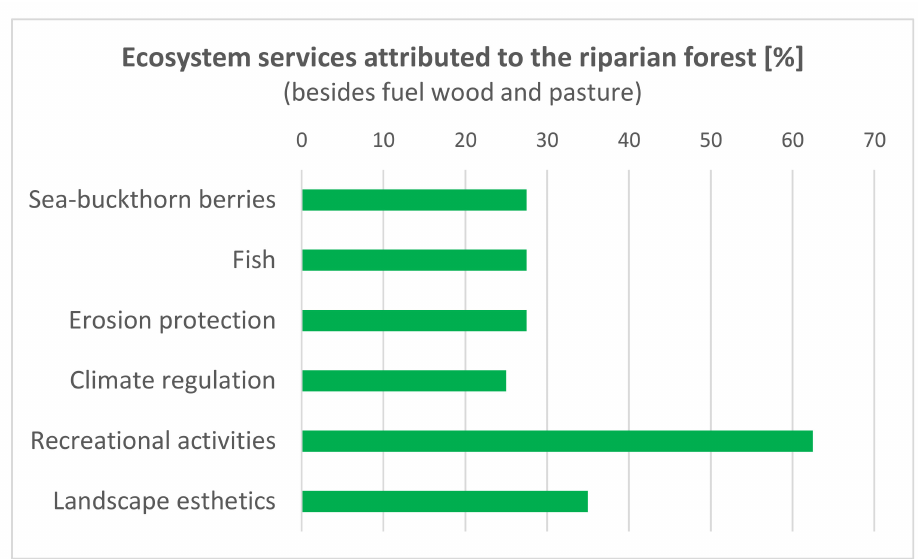
Figure 6. Share of Ak-Tal Village inhabitants attributing certain ecosystem services to their riparian forest (Ak-Tal HHS